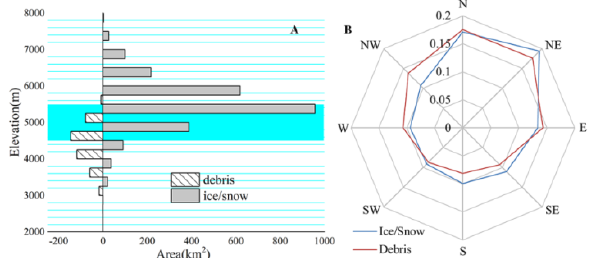
Figure 6. A) Distribution of debris-covered and clean ice/snow area by altitude based on the 2019 RF model classified result. The light blue area represents the equilibrium-line altitude (ELA) of glaciers in the Hunza Valley (4,500 ~ 5,500 m a.s.l.); B) Percentage of debris cover and ice/snow distribution by the